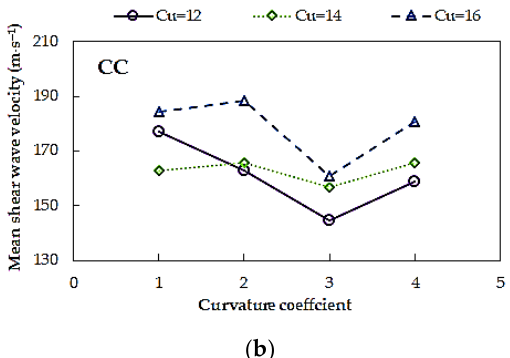
Figure 14. Effect of curvature coefficient ( C C ) on mean shear wave velocity for sands of the same coefficient of uniformity ( C U ) from: ( a ) first time of arrival method and ( b ) cross-correlation method.